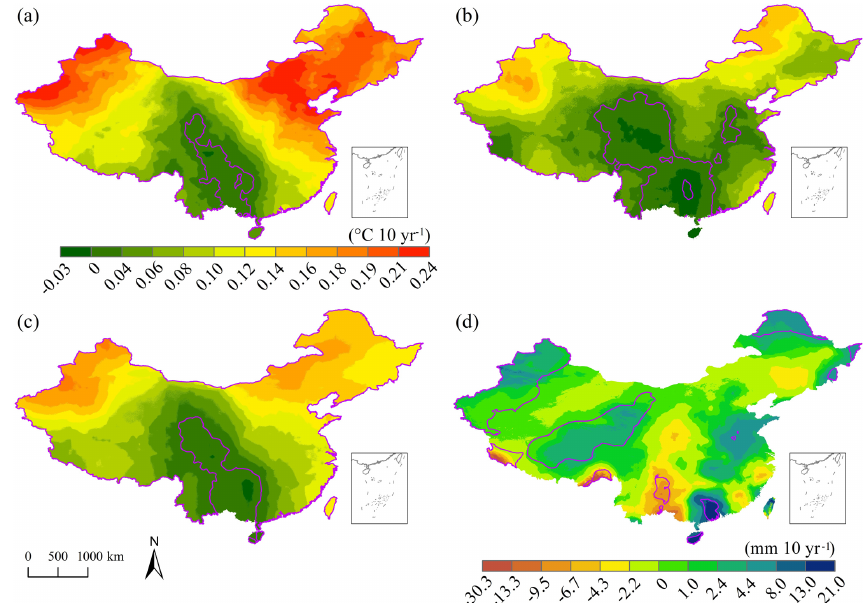
Figure 9. Spatial patterns of the annual trends in TMPs and PRE from 1901 to 2017 across China obtained using the 0.5 (cid:48) downscaled data with bilinear interpolation. Panels (a) – (d) correspond to the annual minimum, maximum, and mean TMPs as well as the annual PRE, respectively. Purple zones indicate locations where trends are significant at the 95% confidence